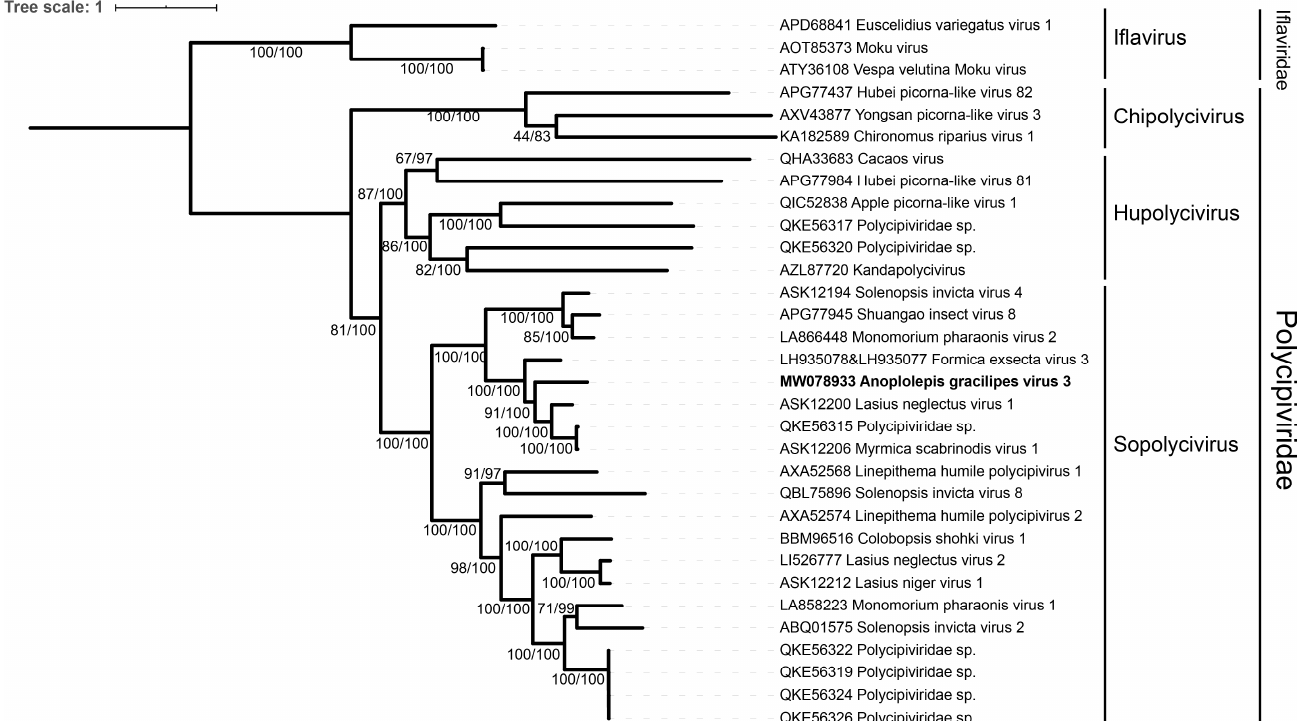
Figure 3. Phylogeny of Anoplolepis gracilipes virus 3, other 28 Polycipiviridae and 3 Iflaviridae viruses based on the ORF5. The phylogenetic tree was constructed by the maximum likelihood and Bayesian inference methods. The numbers at each node indicate the bootstrap supporting value and the posterior probability, respectively. The phylogenetic tree was rooted using three Iflaviridae viruses. The GenBank accessions are followed by virus species names.